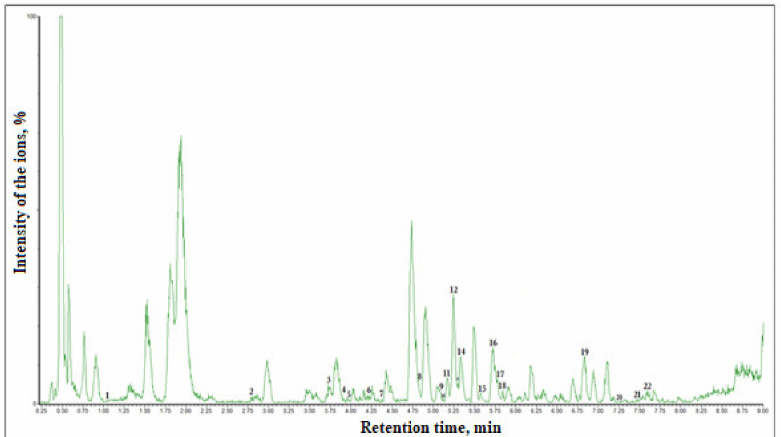
Figure 3. UPLC-ESI-MS / MS chromatogram of the ethanol extract of American cranberry (cultivar ‘Bergman’) fruit sample. The identified and quantitatively evaluated analytes are marked